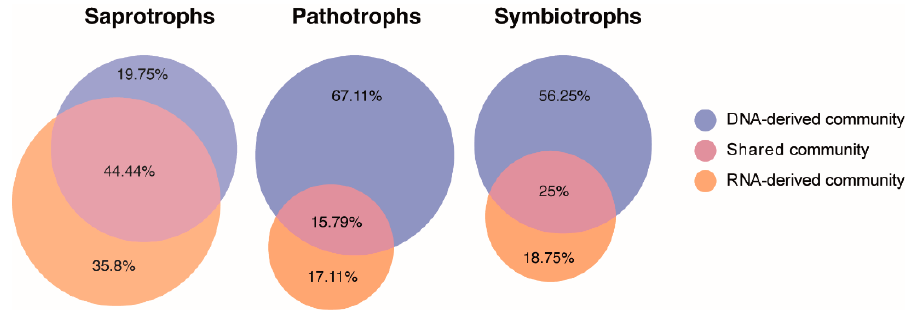
Figure 6. Proportional Venn diagrams presenting the distribution of shared fungal OTUs classified as saprotrophs, pathotrophs and symbiotrophs (based on FUNGuild classification) between DNA- and RNA-derived communities from a subsurface aquatic habitat. 304